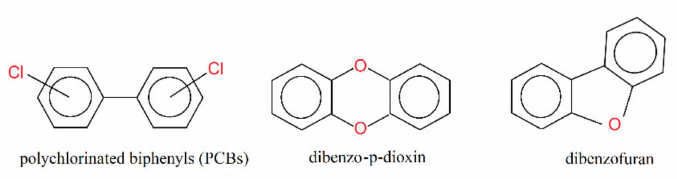
Figure 1. Chemical structures of the toxic chemical compounds into transformer’s mineral oil; polychlorinated biphenyls (PCBs), dibenzo-p-dioxin, and